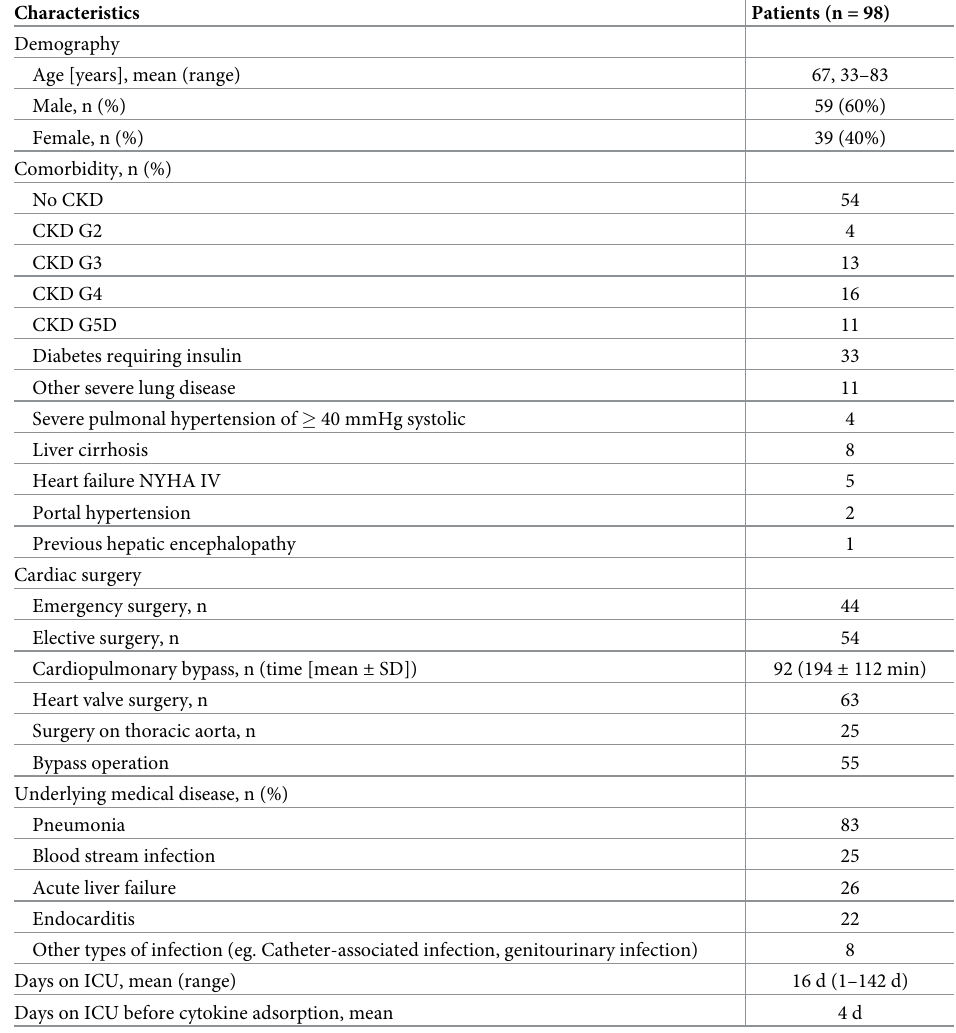
Table 1. Patients